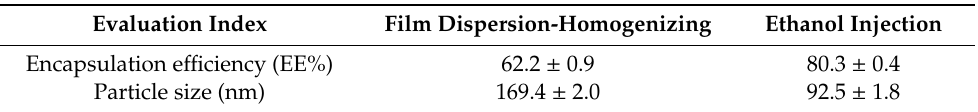
Table 2. E ff ect of di ff erent VD 3 liposomes preparation methods on the encapsulation e ffi ciency and size distribution ( n = 3).